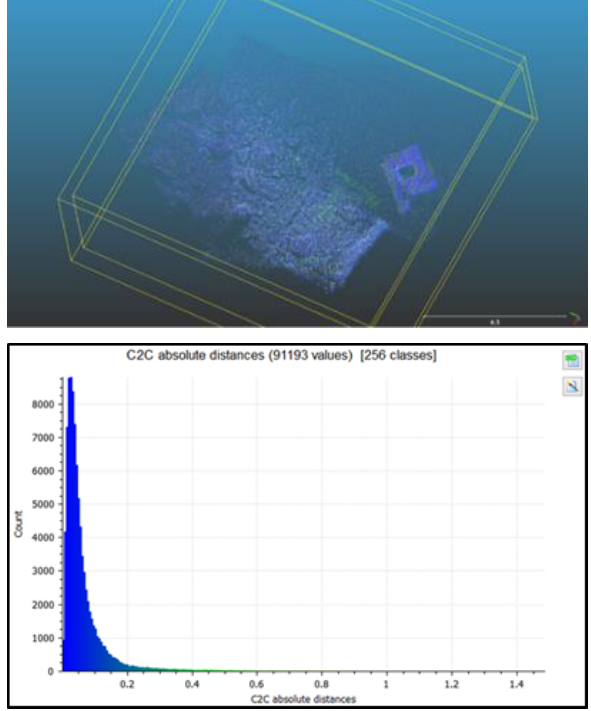
Figure 6. Optical (a) and graphical (b) representation of the difference between the two sparse clouds As it is represented in Figure 6, the absolute differences between the two sparse clouds are smaller than 0.2 units. Even though the differences are small for this specific data set, High parameter has been chosen for the rest of the tests. In photo alignment process no pair preselection has been